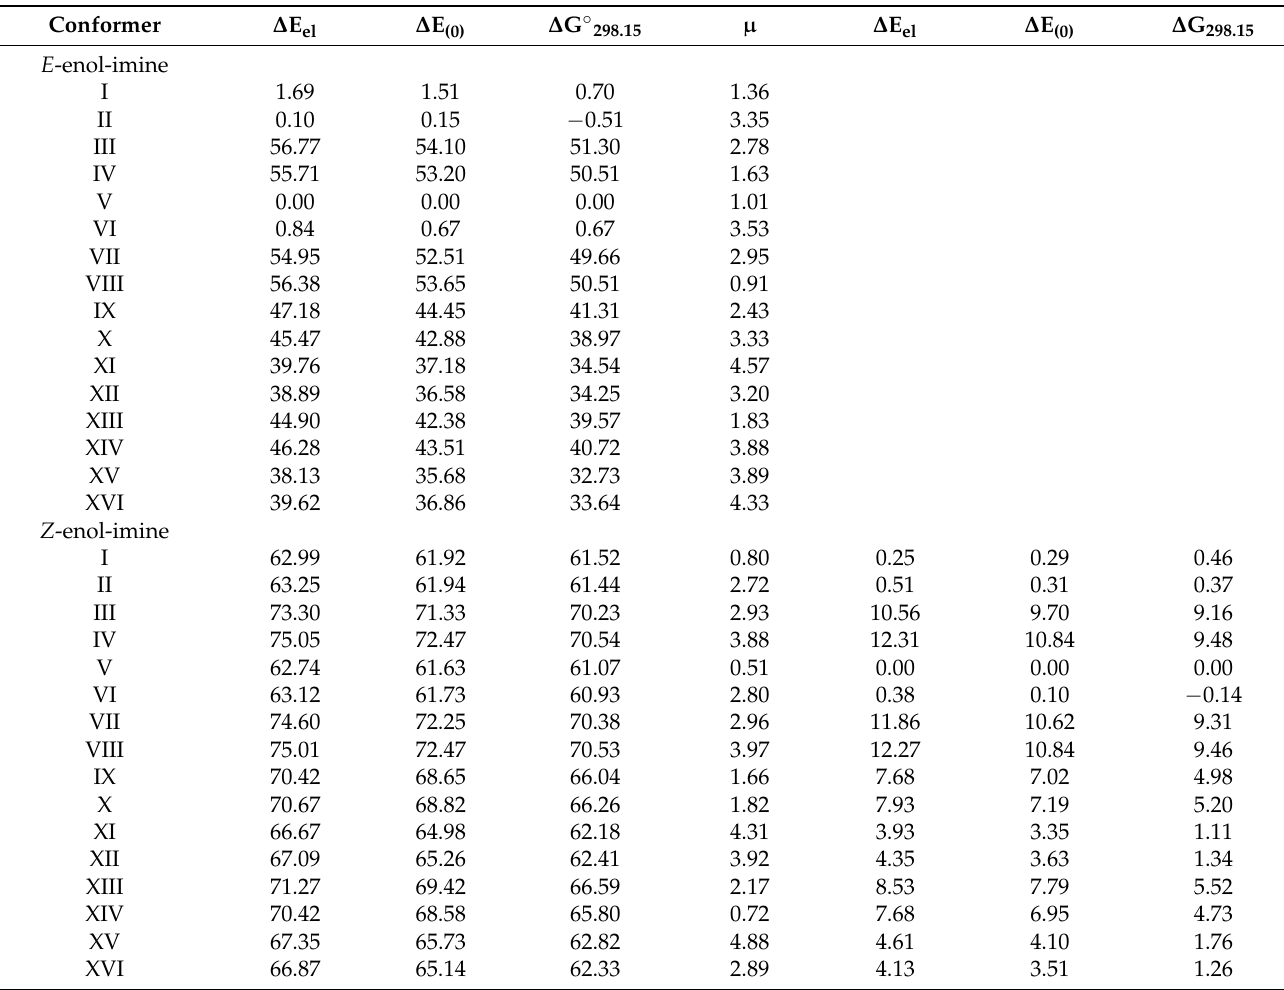
Table 2. B3LYP/6-311++G(d,p) calculated relative electronic energies ( ∆ E el ), zero-point corrected relative energies ( ∆ E (0)